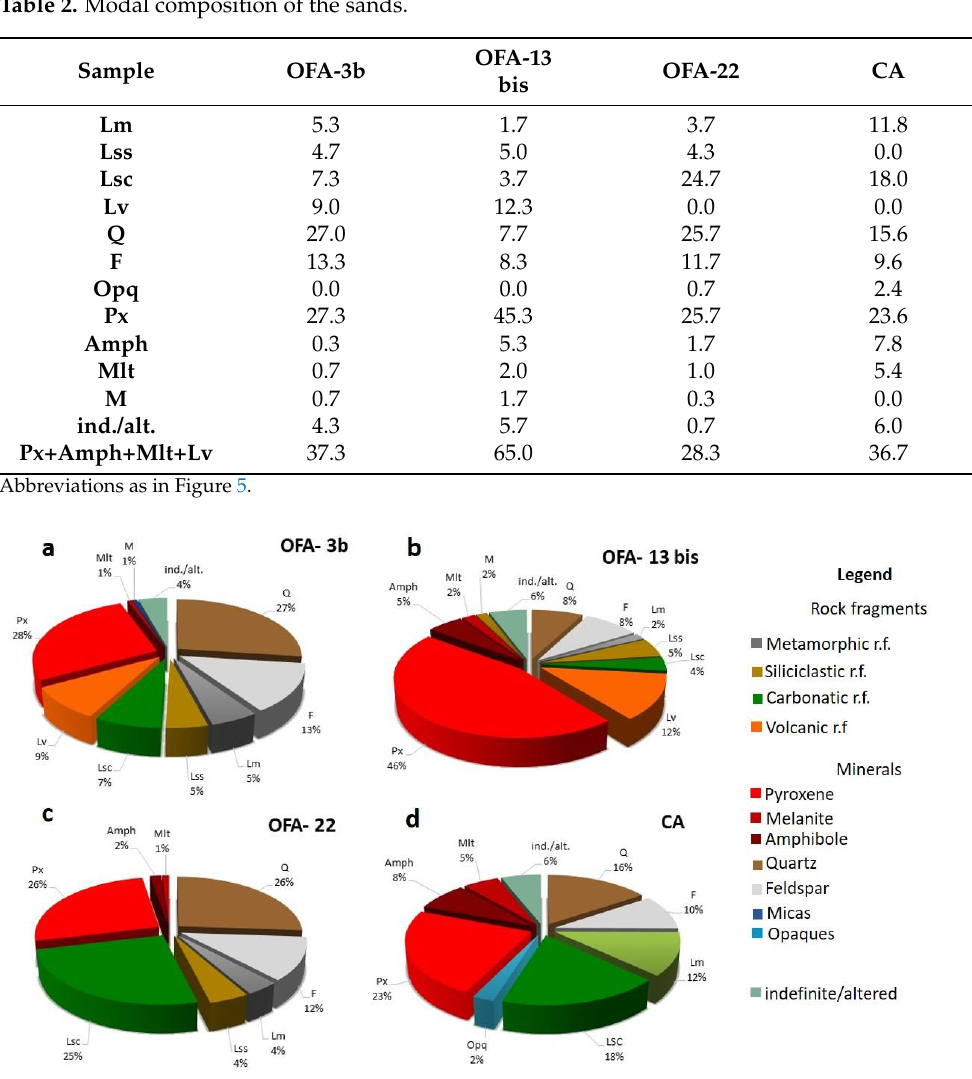
Figure 5. Modal composition of the sands of the studied samples. ( a – c ): samples collected along the course of the Ofanto River, modified after [8]; ( d ): sample CA collected from the Cilento Beach. Table 2. Modal composition of the sands.